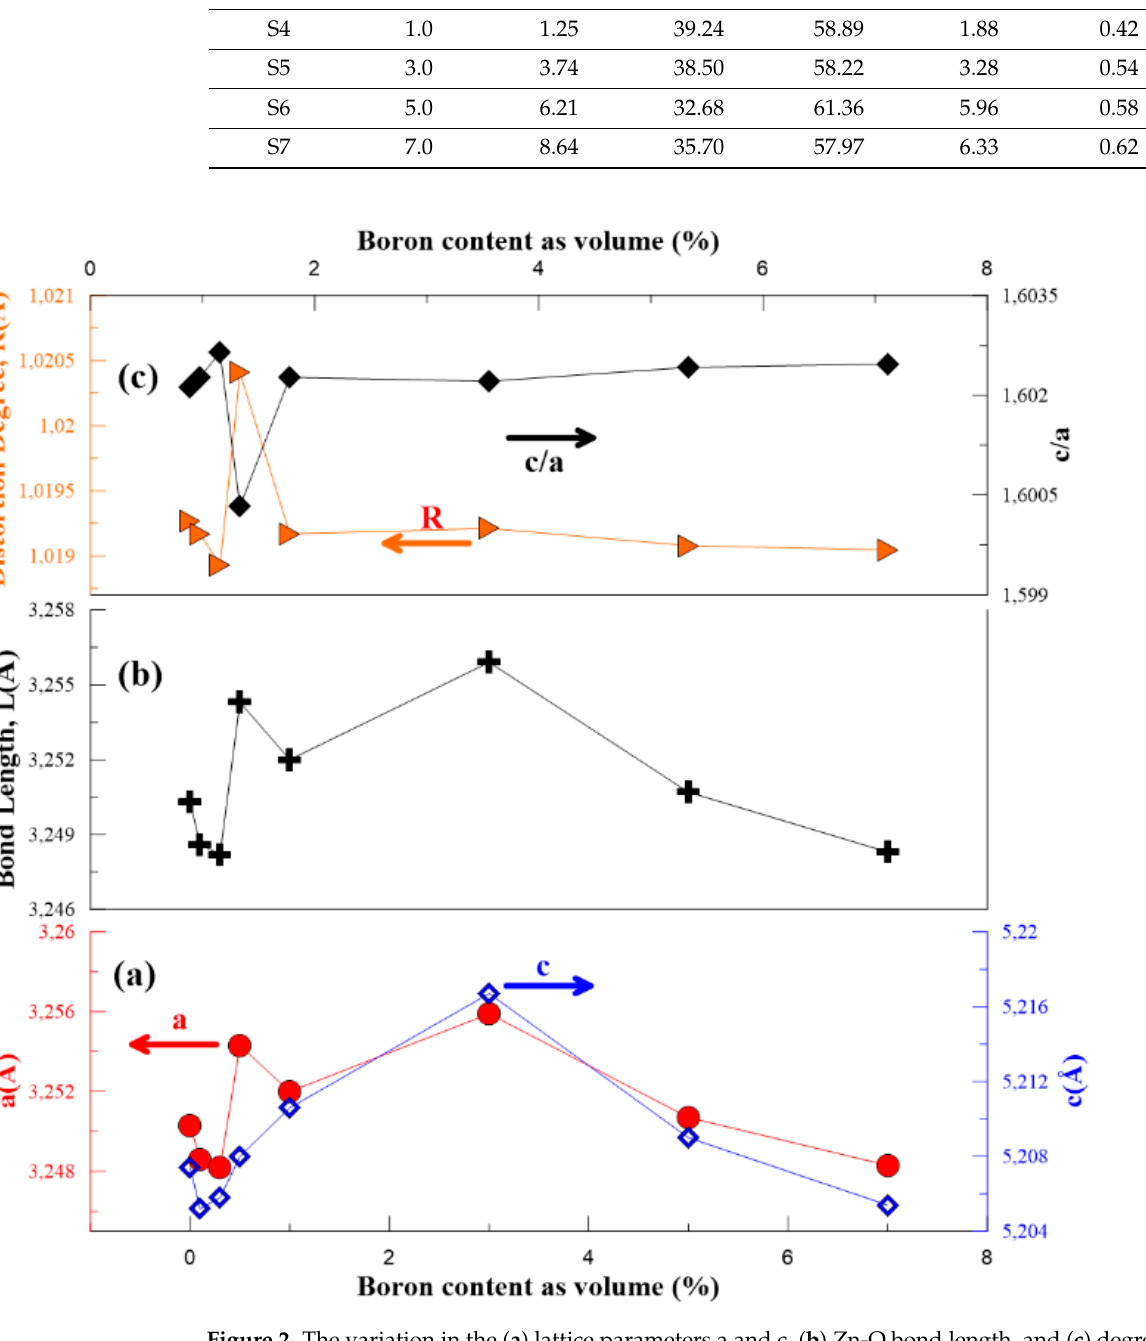
Figure 2. The variation in the ( a ) lattice parameters a and c, ( b ) Zn-O bond length, and ( c ) degree of lattice distortion and ratio as a function of boron content by